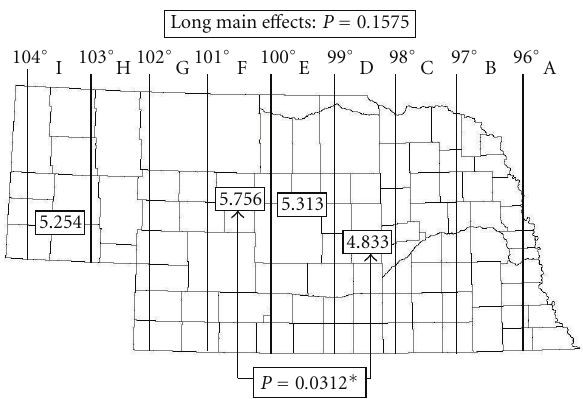
Figure 5: Mean pronotal color by code for Cicindela denverensis by longitudinal region. Significant di ff erences between longitudes shown by arrows and mean value presented in each longitudinal grouping. Fixed e ff ects presented at top. No latitude by longitude interactions